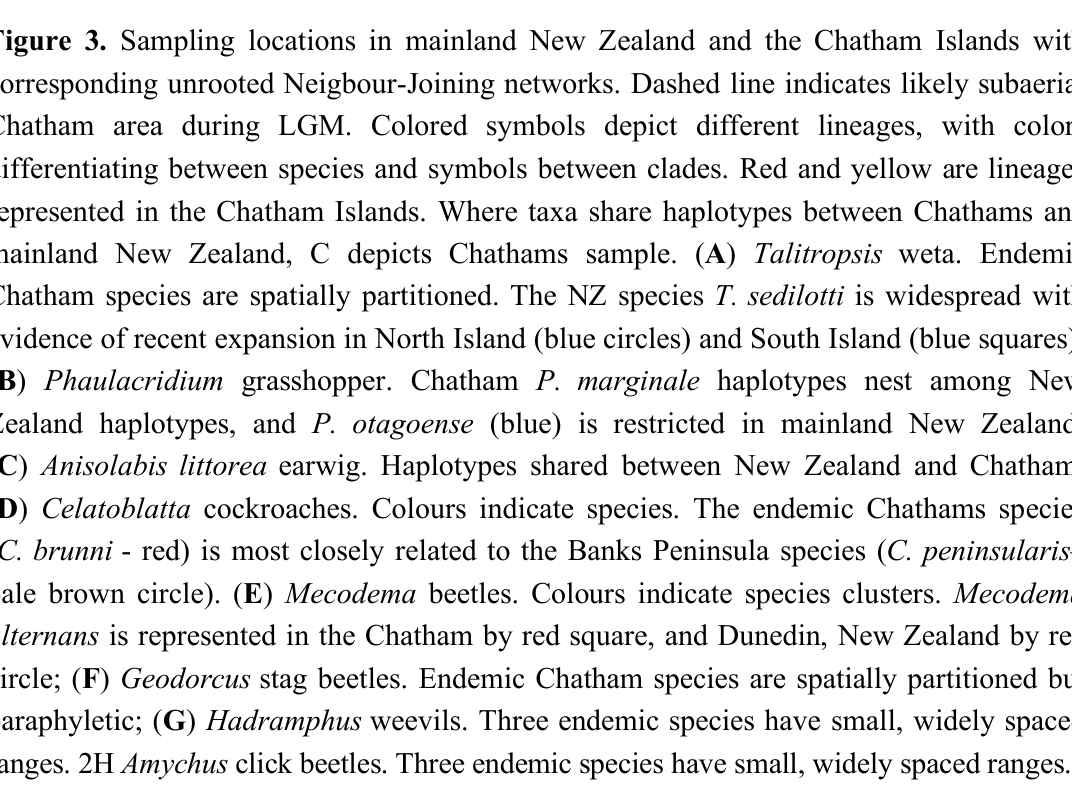
Figure 3. Sampling locations in mainland New Zealand and the Chatham Islands with corresponding unrooted Neigbour-Joining networks. Dashed line indicates likely subaerial Chatham area during LGM. Colored symbols depict different lineages, with colors differentiating between species and symbols between clades. Red and yellow are lineages represented in the Chatham Islands. Where taxa share haplotypes between Chathams and mainland New Zealand, C depicts Chathams sample. ( A ) Talitropsis weta. Endemic Chatham species are spatially partitioned. The NZ species T. sedilotti is widespread with evidence of recent expansion in North Island (blue circles) and South Island (blue squares); ( B ) Phaulacridium grasshopper. Chatham P. marginale haplotypes nest among New Zealand haplotypes, and P. otagoense (blue) is restricted in mainland New Zealand; ( C ) Anisolabis littorea earwig. Haplotypes shared between New Zealand and Chatham; ( D ) Celatoblatta cockroaches. Colours indicate species. The endemic Chathams species ( C. brunni - red) is most closely related to the Banks Peninsula species ( C. peninsularis – pale brown circle). ( E ) Mecodema beetles. Colours indicate species clusters. Mecodema alternans is represented in the Chatham by red square, and Dunedin, New Zealand by red circle; ( F ) Geodorcus stag beetles. Endemic Chatham species are spatially partitioned but paraphyletic; ( G ) Hadramphus weevils. Three endemic species have small, widely spaced ranges. 2H Amychus click beetles. Three endemic species have small, widely spaced